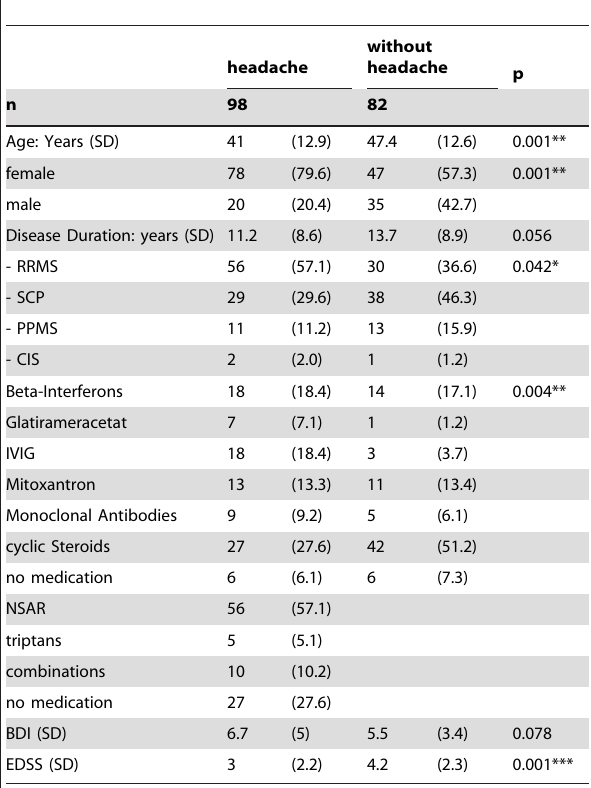
Table 3. Comparison of sociodemographic and neurological parameters in MS-patients with and without headaches.